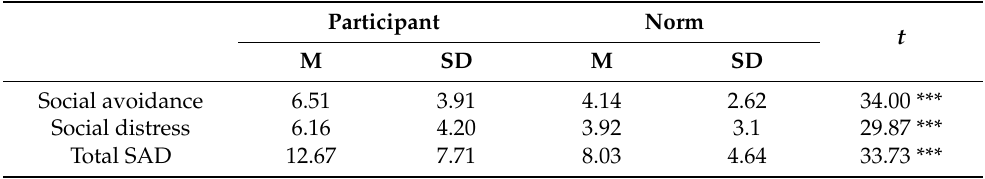
Table 3. Social Anxiety Descriptive